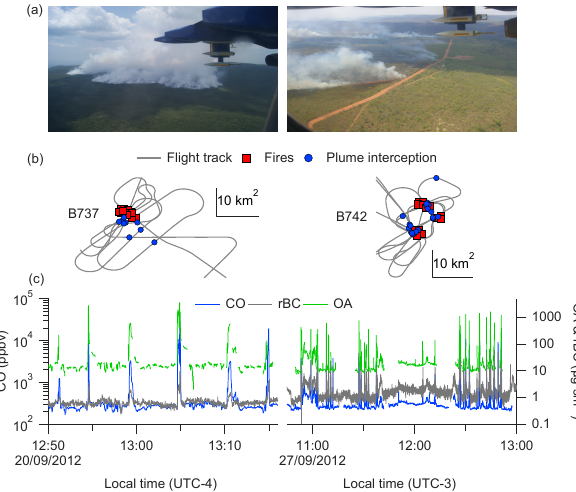
Figure 1. Overview of case studies used in the analysis with the Rondônia flight (B737) shown on the left and the Tocantins flight (B742) shown on the right. (a) Photographs taken from the aircraft of the Rondônia and Tocantins fires courtesy of William T. Morgan and Axel Wellpott respectively. Full-size photographs are included in the Supplement. (b) Low-level flight tracks including MODIS hotspot data from Terra and Aqua overpasses for the dates of in- terest. Plume interceptions are also marked. 10km 2 box represents scale for flight-track. (c) Time series of CO, rBC and OA during the near-field fire sampling periods of the flight.